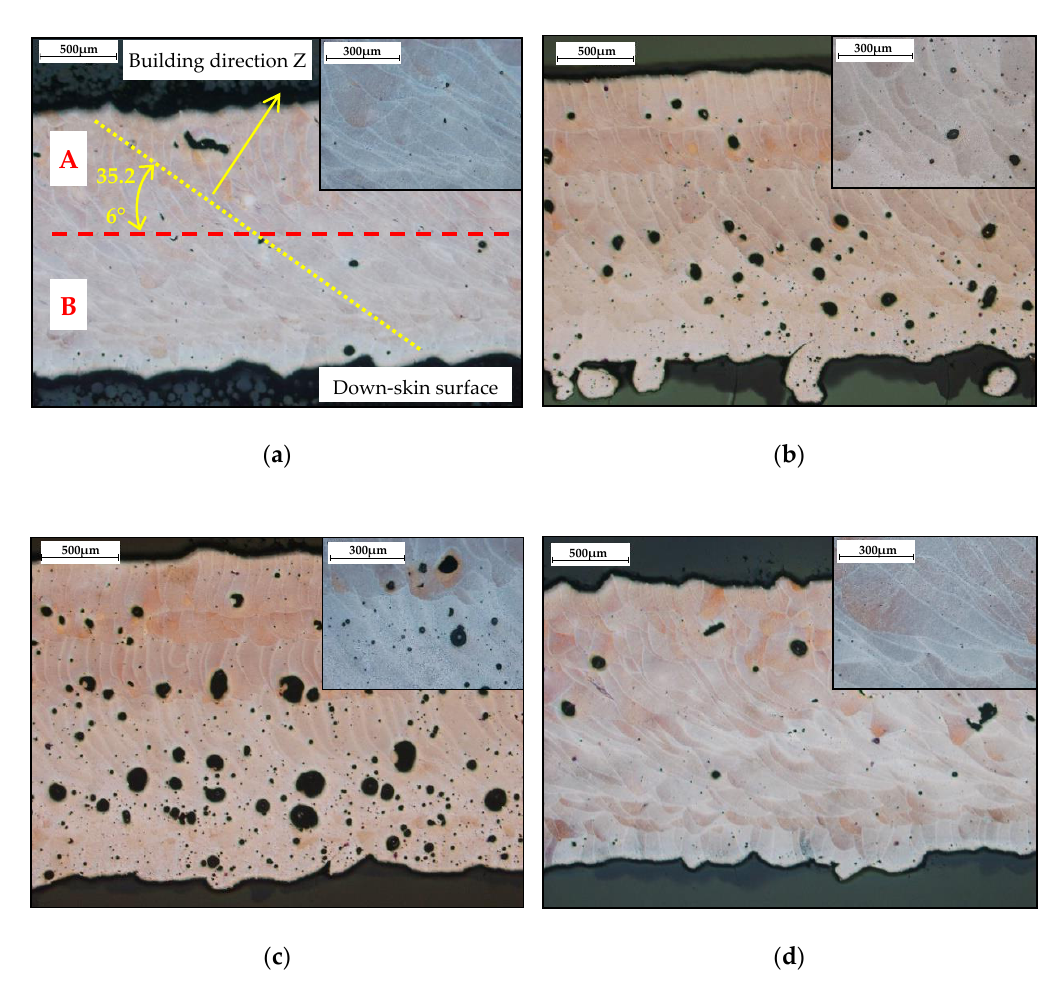
Figure 15. Microstructure of the struts ( a ) LP 250 W, LS 1400 mm/s, E in 9.17 J, E lin 0.18 J/mm with description common for all pictures; ( b ) LP 300 W, LS 500 mm/s, E in 13.54 J, E lin 0.6 J/mm ( c ) LP 350 W, LS 500 mm/s, E in 15.43 J, E lin 0.7 J/mm; ( d ) LP 400 W, LS 1700 mm/s, E in 7.56 J, E lin 0.24 J/mm.